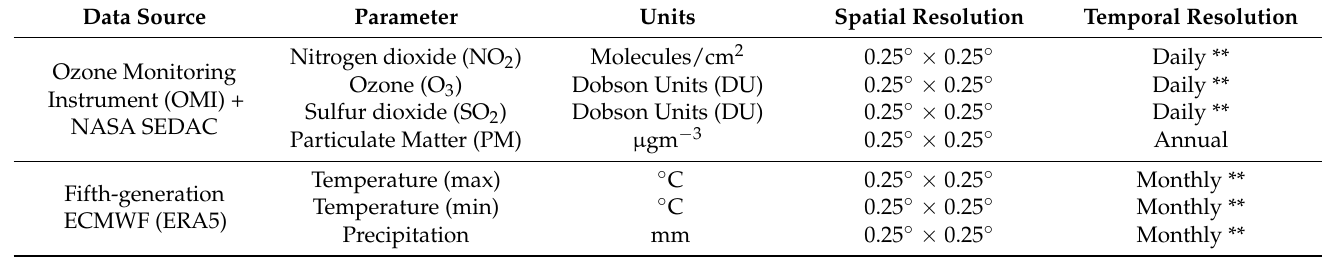
Table 1. Detailed information on data used in the current study. Note: ** Data were averaged into annual values.